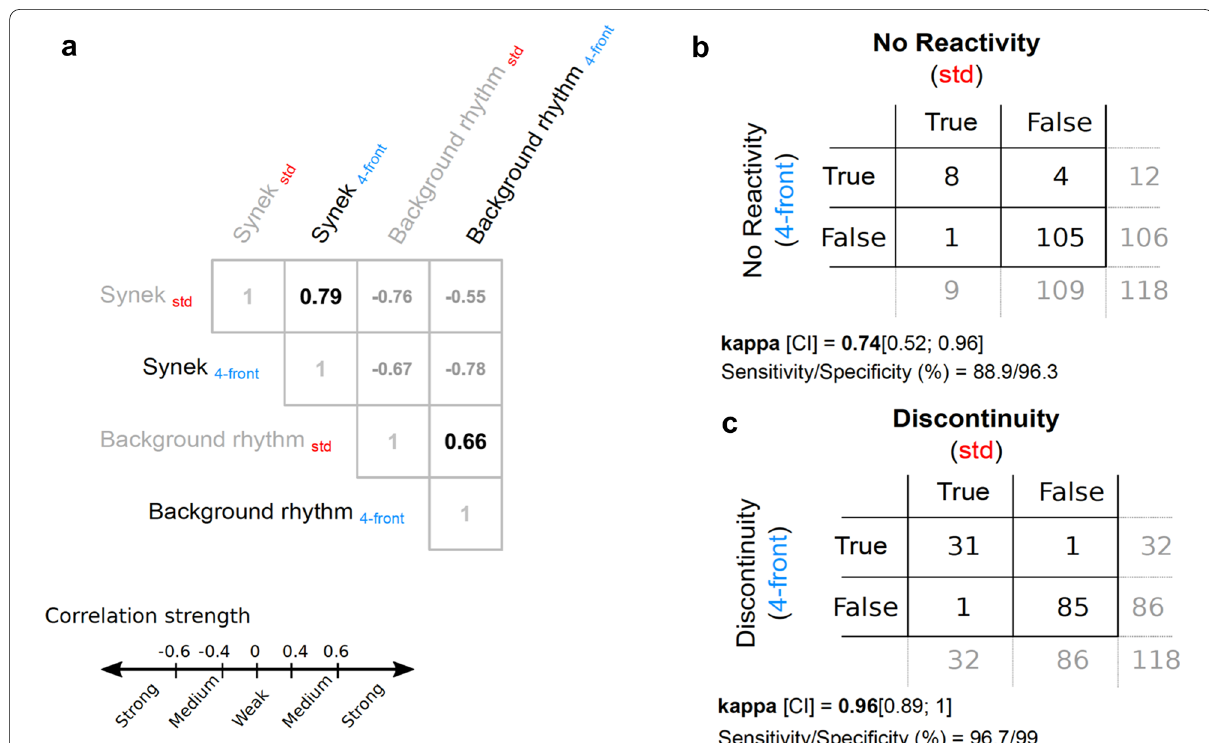
Fig.2 Similarity between EEG variables computed from the standard and frontal montages. a Spearman correlation matrix showing strong association between standard (std, red fonts) and frontal (4‑front, blue fonts) derived Synek score ( ρ show strong association between std and 4‑front estimated background rhythm ( ρ montages computed for the absence of reactivity ( b ) and the discontinuity ( c )